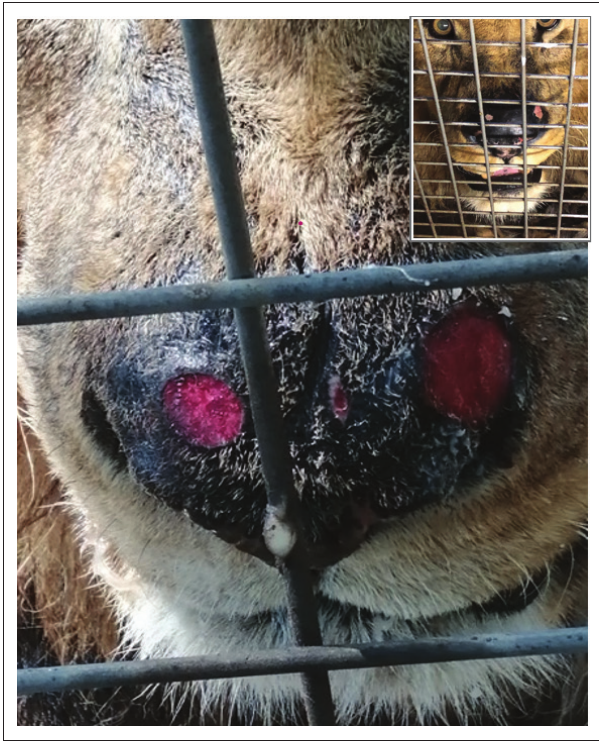
FIGURE 1: Photograph of the nasal planum of the lion showing two well- demarcated ulcerative lesions. Inset: Nasal planum 2 months after diagnosis and receiving